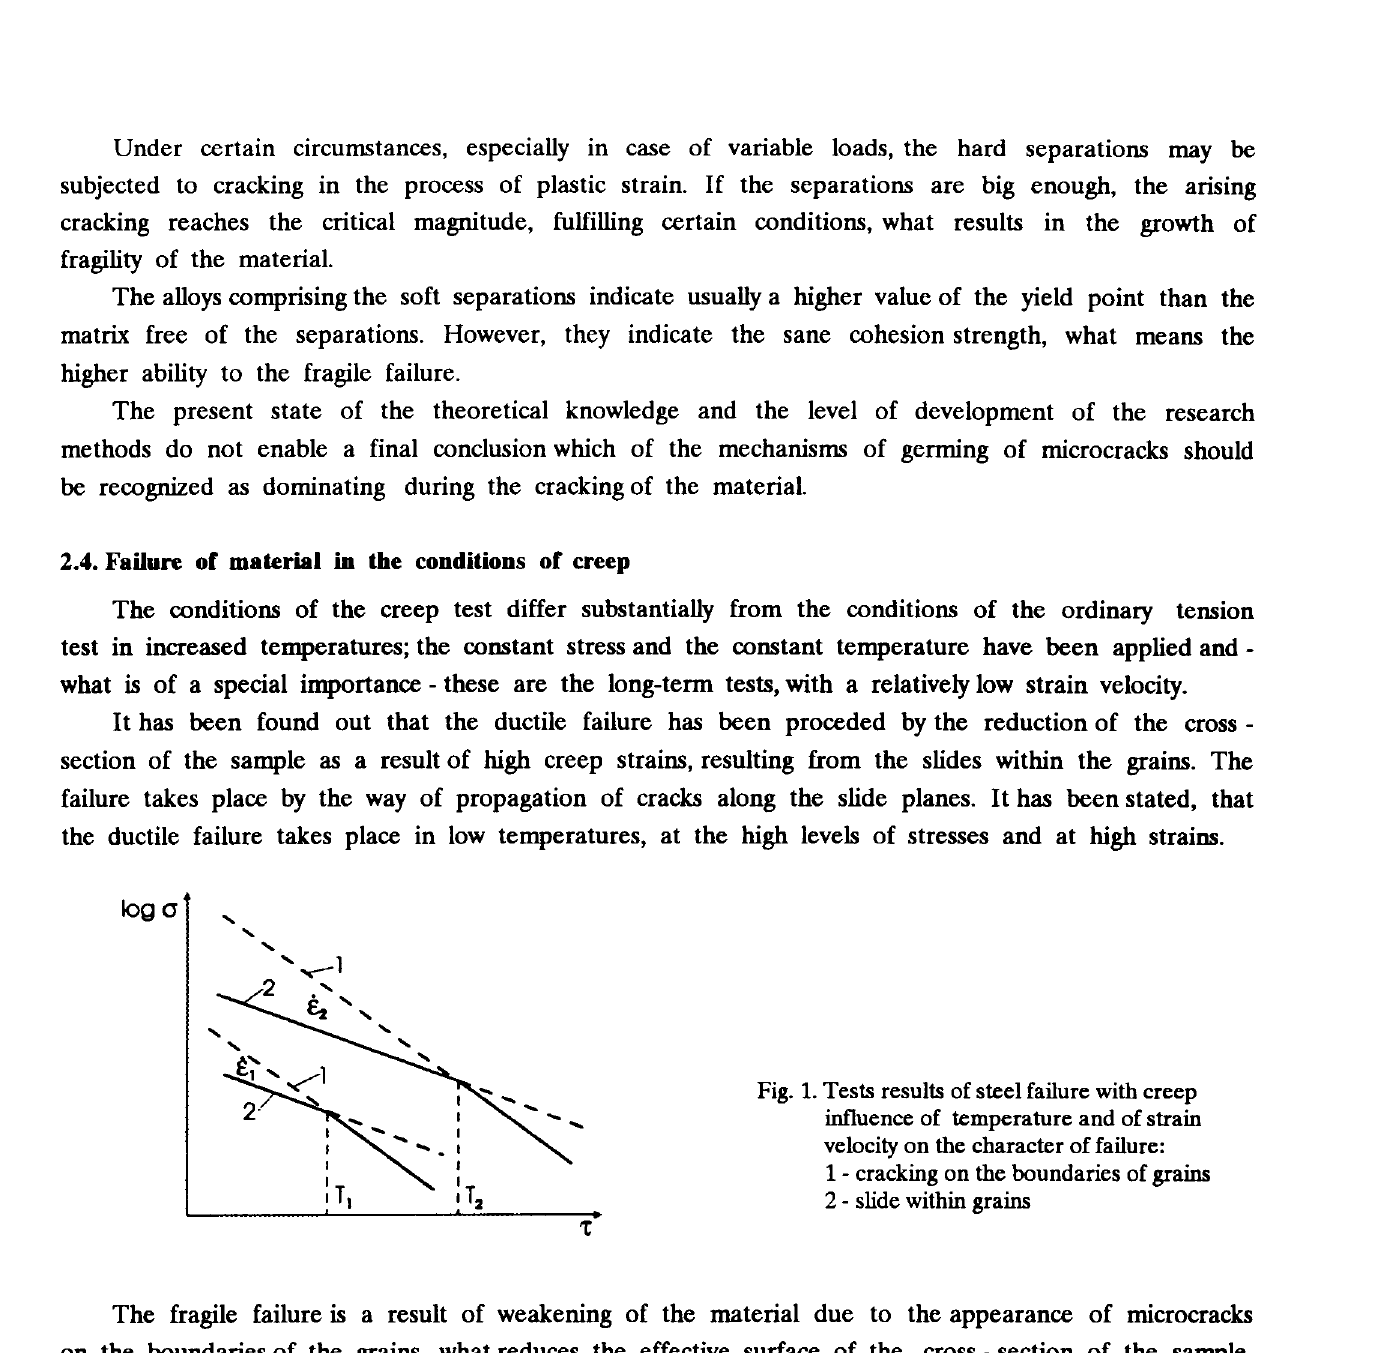
Fig. 1. Tests results of steel failure with creep influence of temperature and of strain velocity on the character of failure: 1 - cracking on the boundaries of grains 2 - slide within